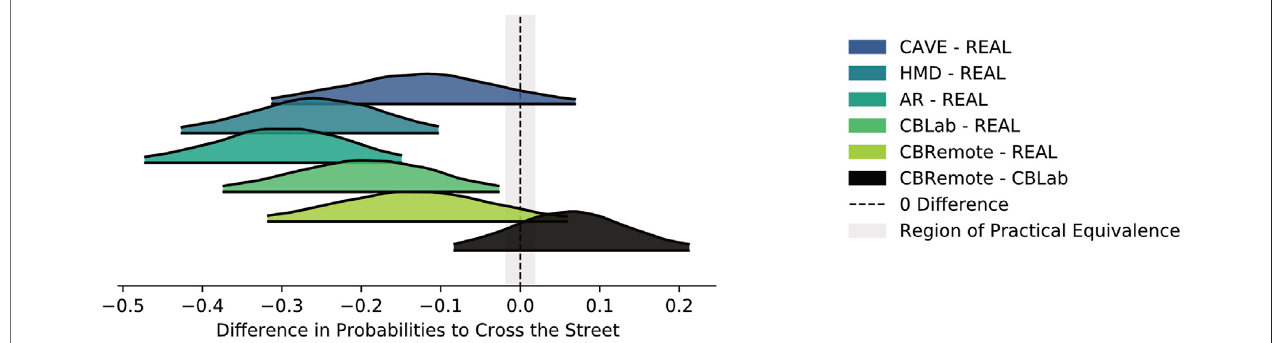
FIGURE6| Differenceinposteriorprobabilitiesofcrossingthestreet (fora3sgapandat30 km / h )betweenthesimulatorsandthereal-worldsetting, andbetween the two Cardboard settings.